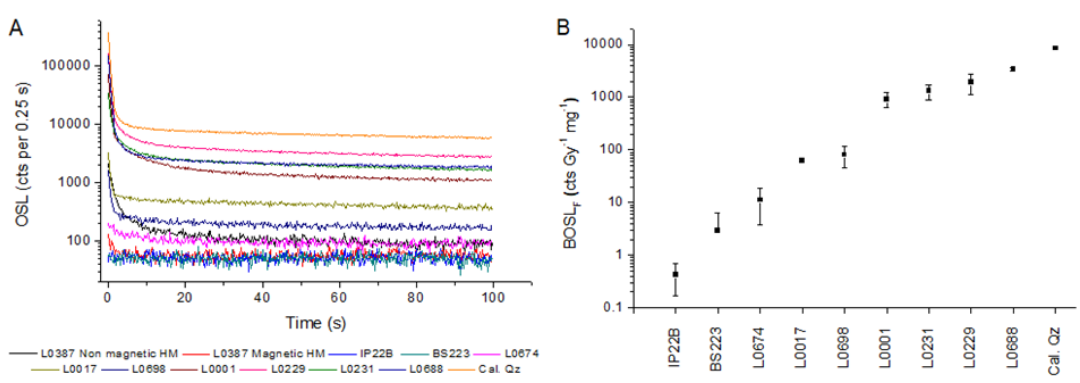
Figure 1. ( A ) OSL decay curves (step 5 of the protocol in Table 2) of quartz with different sensitivities. OSL decay curves of nonmagnetic and magnetic heavy minerals are also shown for comparison. Aliquots irradiated with 50 Gy. ( B ) Range of BOSL F sensitivity comprised in the studied quartz samples. Each sample is represented by the average of three aliquots. Error bars correspond to the standard deviation. Sample type is described in Table 1. Table 5. Average ( n = 3 aliquots) OSL sensitivity ( ± standard deviation) of studied quartz samples. The OSL sensitivity of heavy minerals concentrates from coastal sands (samples L0387 and L0393) are also shown for comparison. The OSL sensitivities of magnetic (M) and nonmagnetic (NM) heavy minerals were calculated in the same way as the BOSL F . OSL signal was not detected for the magnetic heavy mineral fraction of sample L0387. A given dose of 50 Gy was used for all aliquots. Sample %BOSL